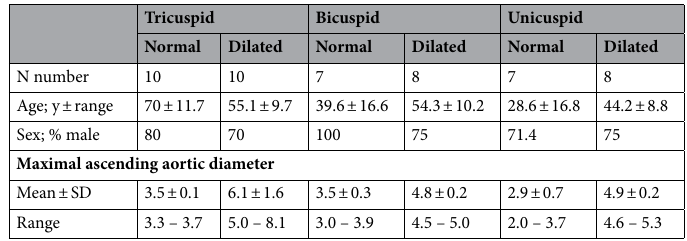
Table 2. Patient characteristics based on aortic